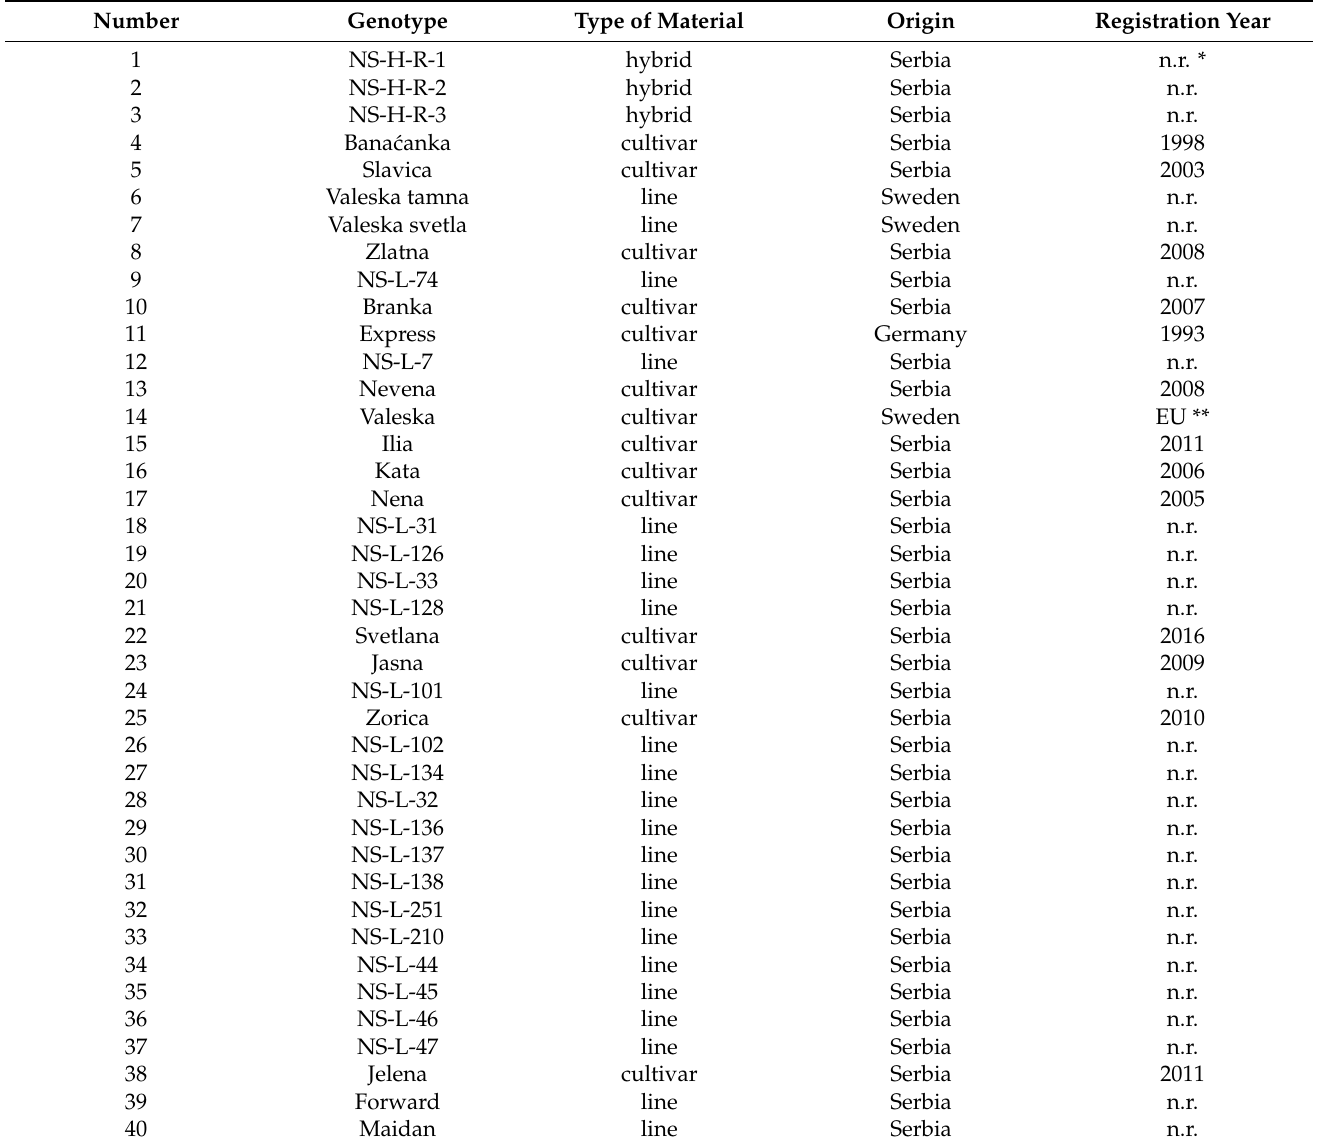
Table 1. Winter rapeseed genotypes tested during